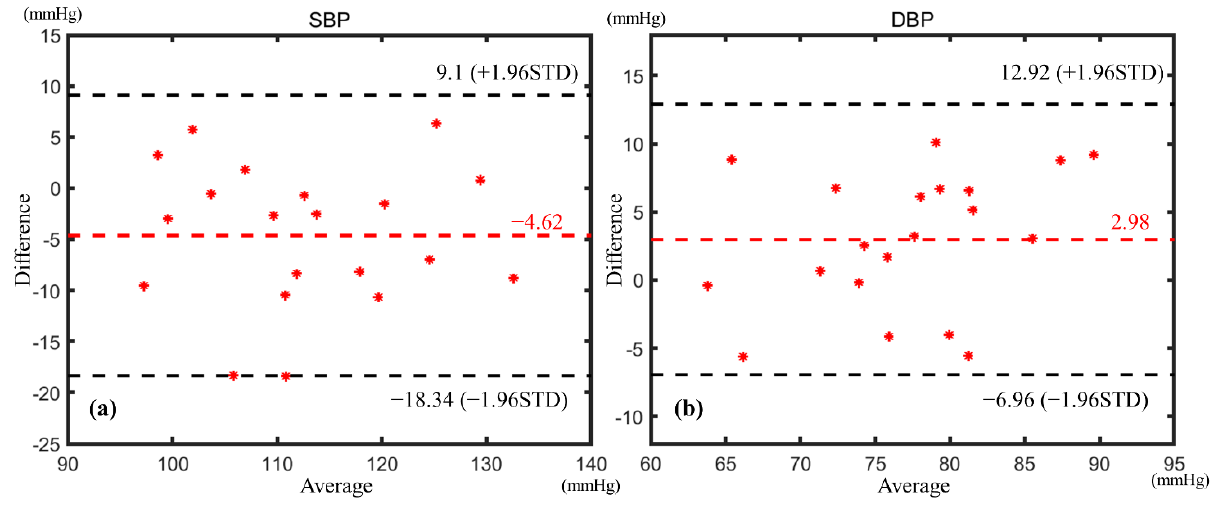
Figure 11. Bland – Altman analysis of ( a ) SBP and ( b ) DBP.